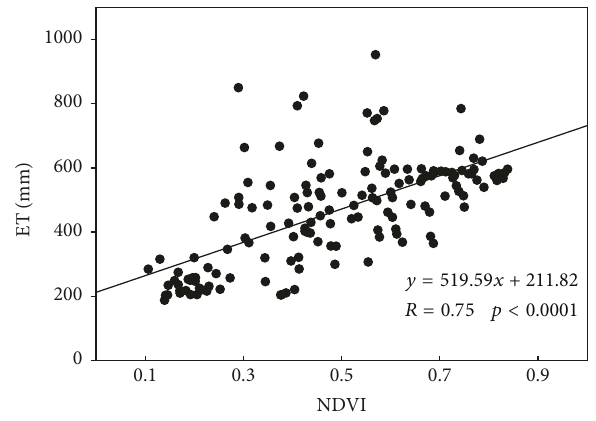
Figure 9: Relationship of NDVI with